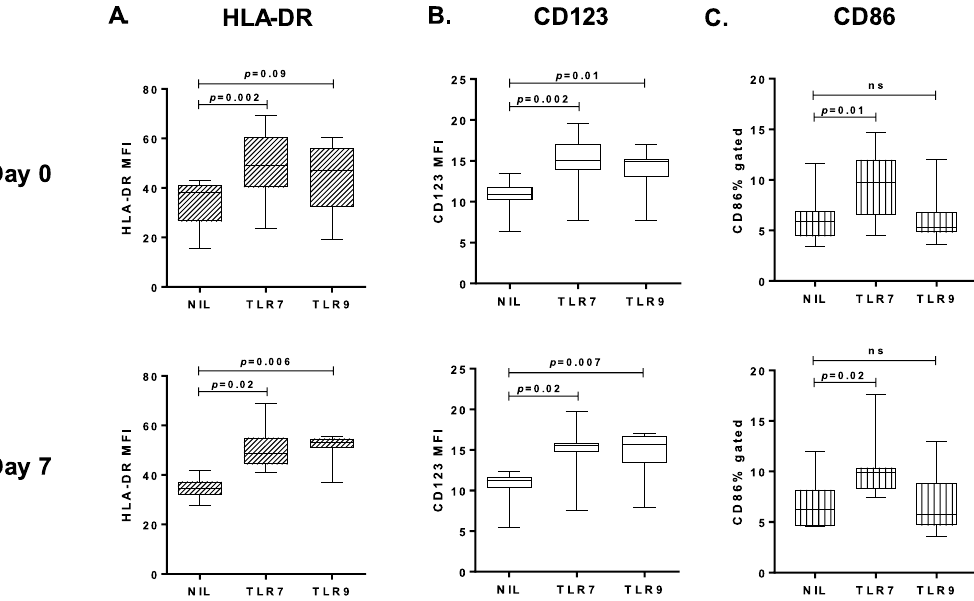
Figure 5. Increased HLA-DR, CD123 and CD86 expression on pDC upon TLR stimulation. ( A ) pDC HLA-DR expression ( B ) pDC CD123 expression and ( C ) pDC CD86 percent gated on day 0 or day 7, in three conditions: no stimulation and after TLR7 or TLR9 stimulation, n = 8. Box plots show the minimum, maximum,